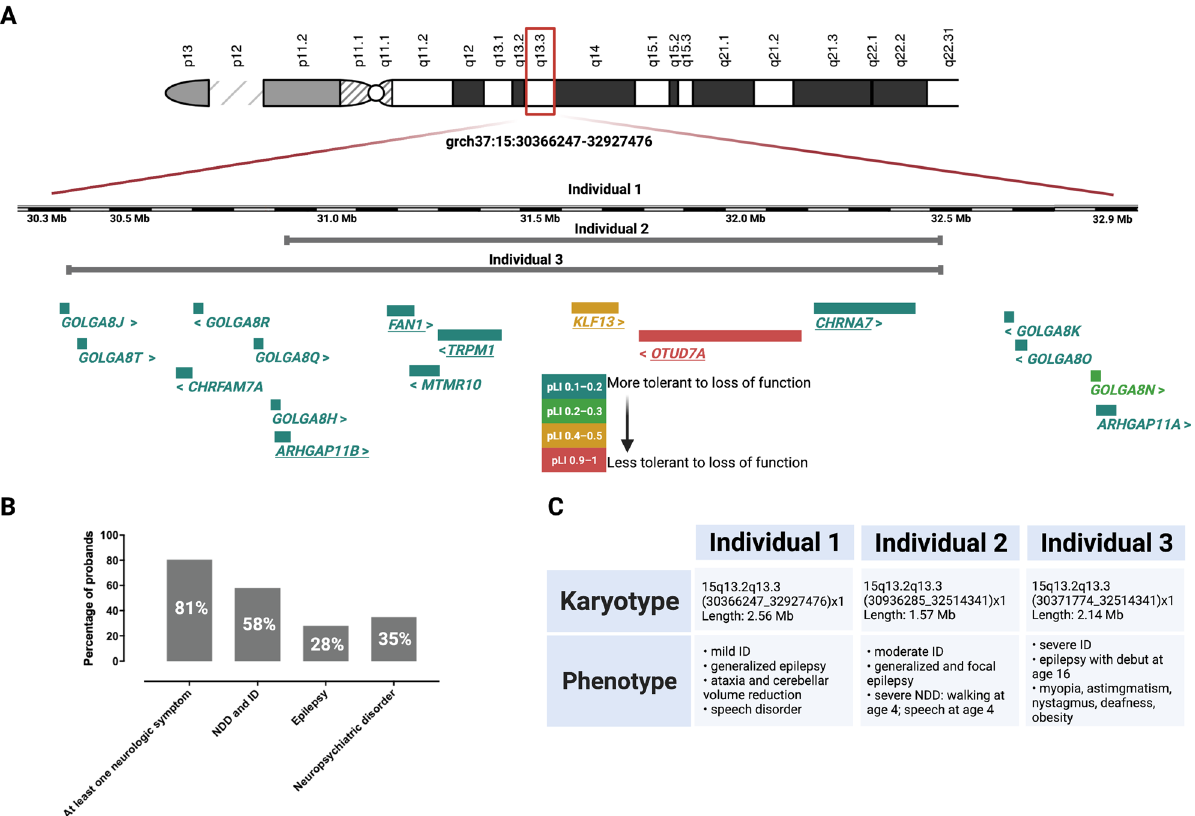
Figure 1. Overview of the 15q13.3 locus and symptoms associated with the microdeletion. ( A ) Schematic representation of the 15q13.3 microdeletion region. Protein coding genes within the region are shown beneath chromosome 15. The color legend corresponds to the pLI score as a measure of loss-of-function deleteriousness 41 . Underlined genes have been considered candidates that are responsible for the observed phenotypes ( CHRNA7 3,4 , OTUD7A 5,6 , FAN1 7 , ARHGAP11B 8 , TRPM1 9 , KLF13 10 ) ( B ) Individuals with 15q13.3 microdeletion display a heterogenous phenotype which can range from normal development to severe intellectual disability (ID) or neurodevelopmental disorders (NDD). A delineation of the phenotype based on 246 cases revealed predominantly neurologic symptoms of which ID, epilepsy, and neuropsychiatric disorders are most prominent 2 . ( C ) All our individuals carrying the microdeletion displayed intellectual disability, epilepsy, and different additional neuropsychiatric